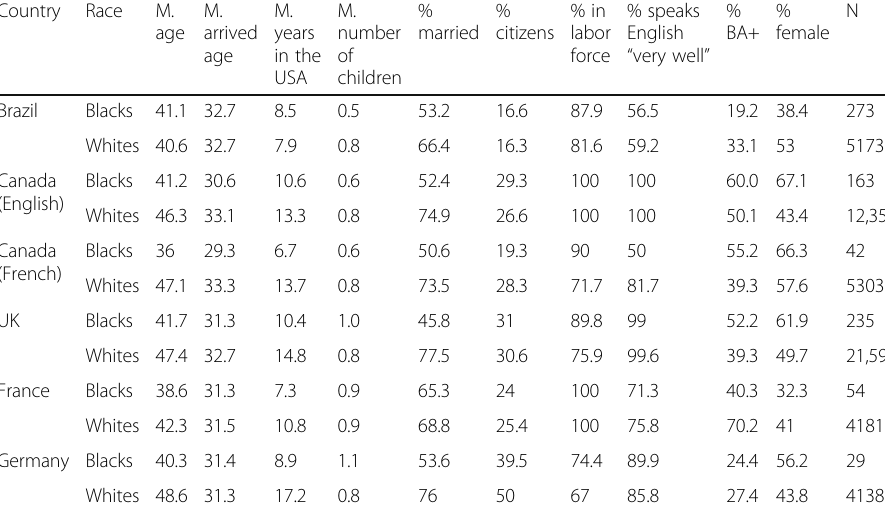
Table 2 Descriptive statistics of immigrant minorities by race, age 25 to 64 Country Race M. M. M. M. age arrived years number age Brazil Canada Blacks 41.2 30.6 (English) Whites 46.3 33.1 Canada Blacks 36 (French) UK Blacks 41.7 31.3 France Germany Blacks 40.3